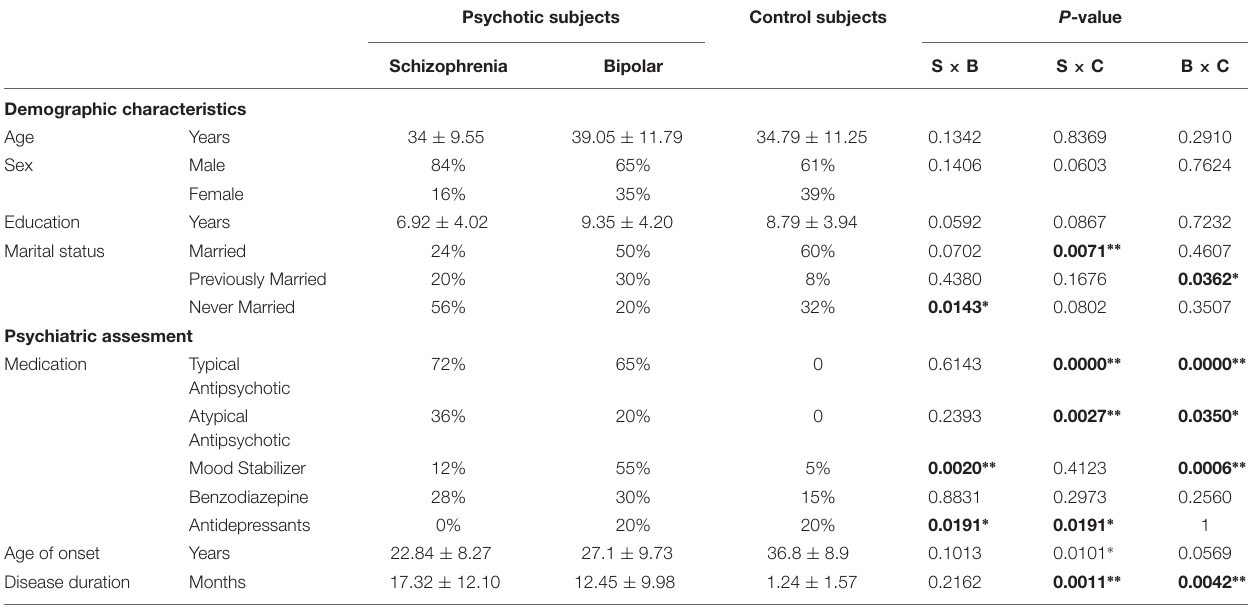
TABLE 1 | Socio-demographic and psychiatric information about the groups investigated.